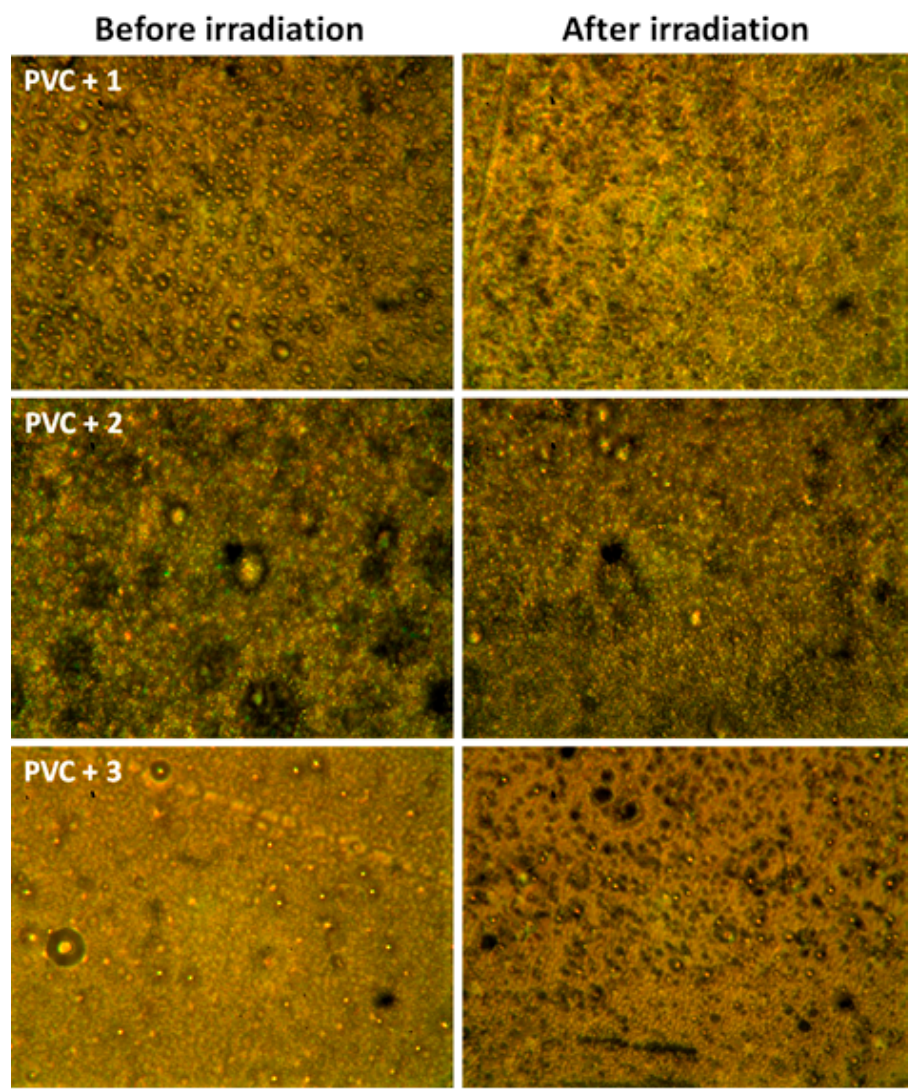
Figure 12. Microscopic images of PVC films containing polyphosphates 1 – 3 (400× magnification).